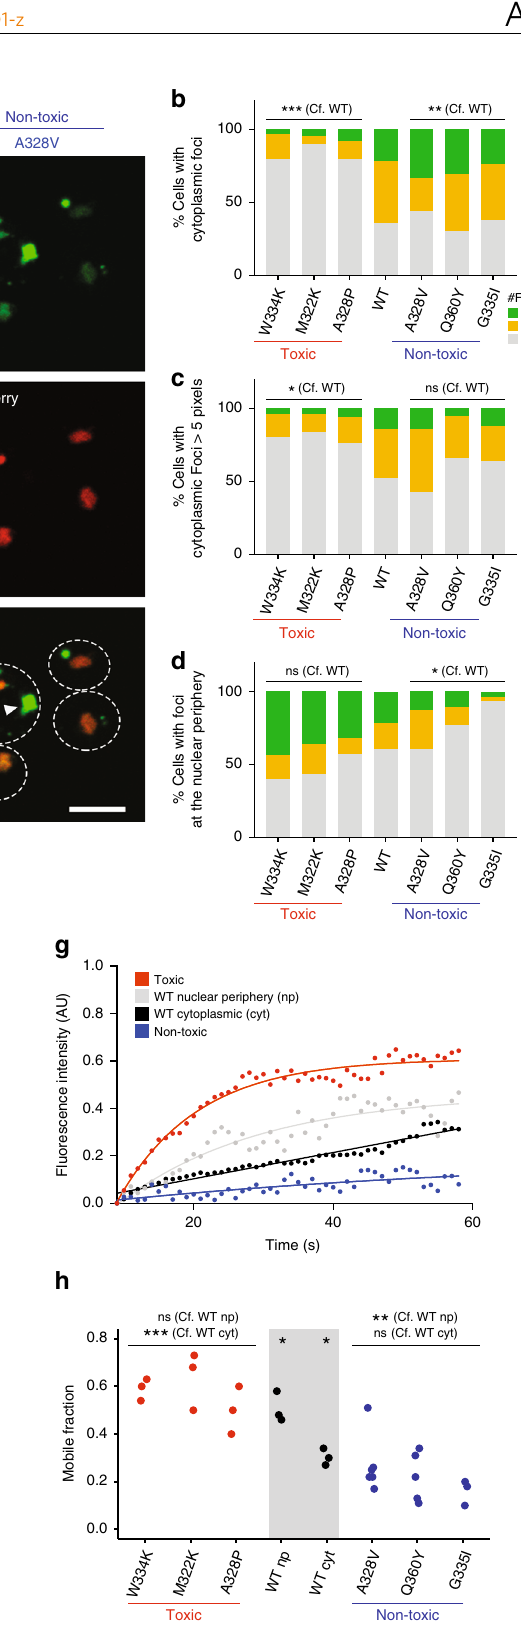
Two classes of cytoplasmic TDP-43 foci . WT TDP-43 localizes to both the nucleus and to the cytoplasm of yeast cells 54,55 (Fig. 3a). In the nucleus, TDP-43 is diffuse, but in the cytoplasm it forms puncta , consistent with previous observations 41,57 . We observe that cytoplasmic WT TDP-43 forms two types